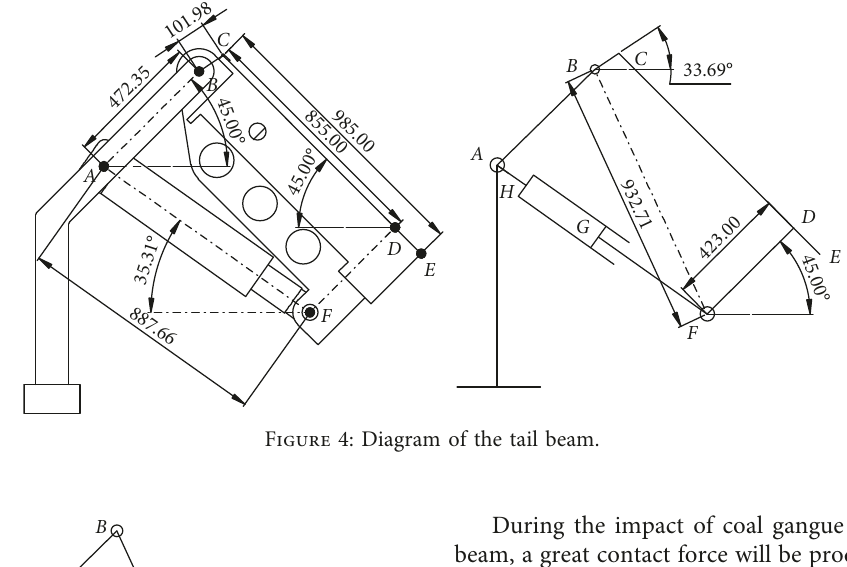
Figure 4: Diagram of the tail beam.